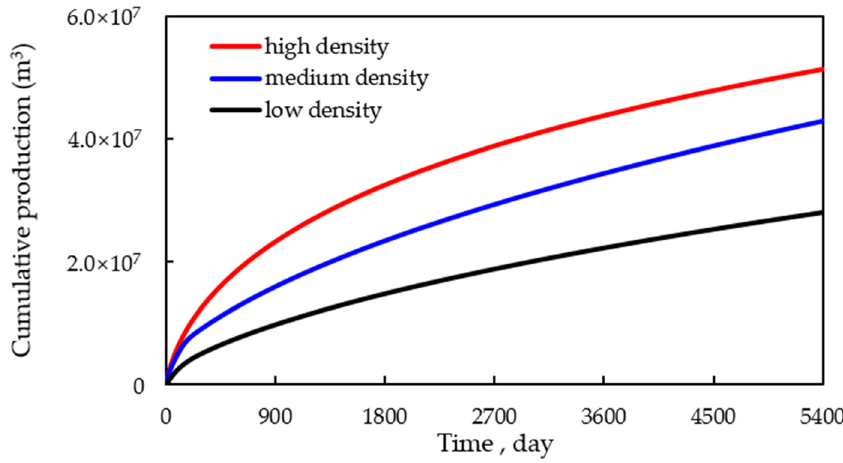
Figure 8. Cumulative production of the well in high, medium, and low fracture density.